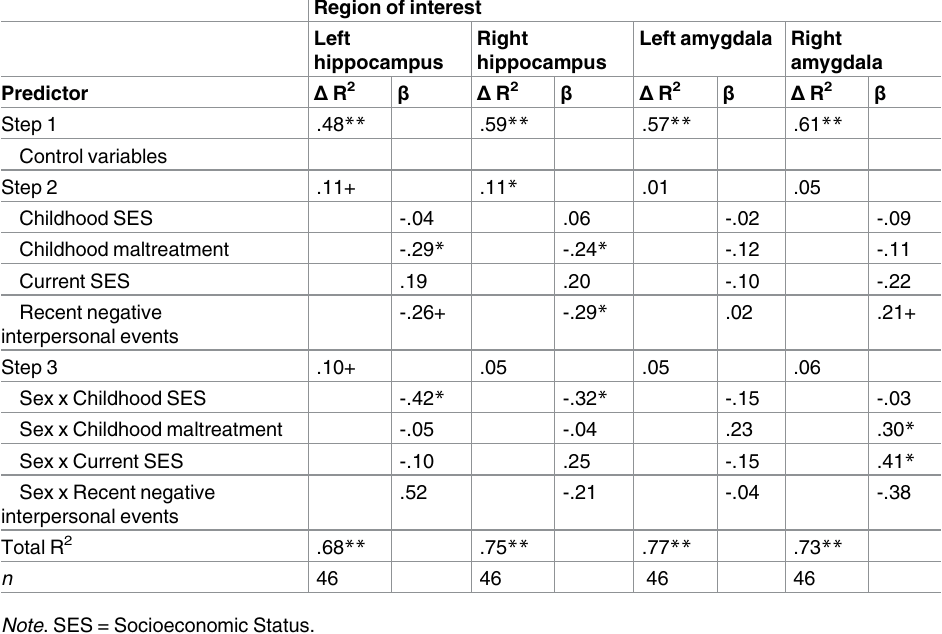
Table 4. Results from hierarchical multiple linear regression using control variables (age, sex, BMI, total brain volume), variables of interest (childhood SES, childhood maltreatment, current SES, and recent negative interpersonal events), and interactions of these variables with sex, to predict volume of the hippocampus and amygdala. Region of interest Right